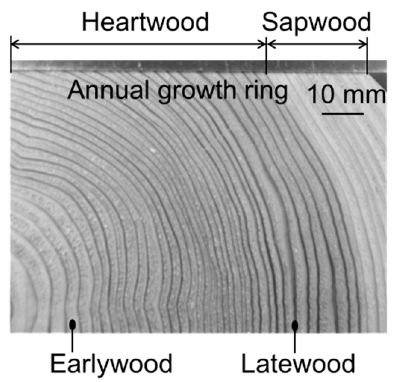
Figure 2. Annual growth ring in Japanese cedar used in present study.